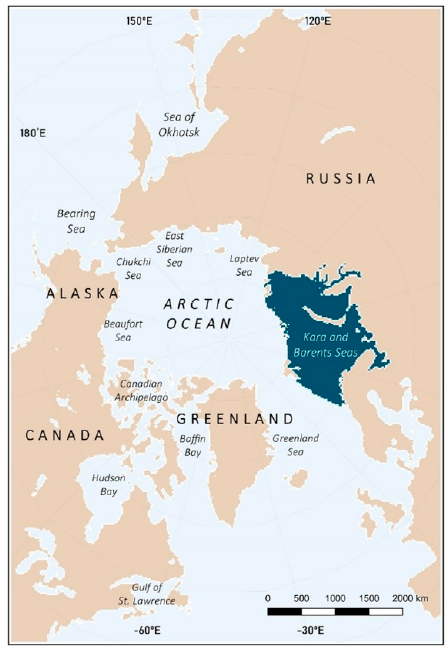
Figure 1. Map of the study area provided by the National Snow and Ice Data Center (NSIDC).